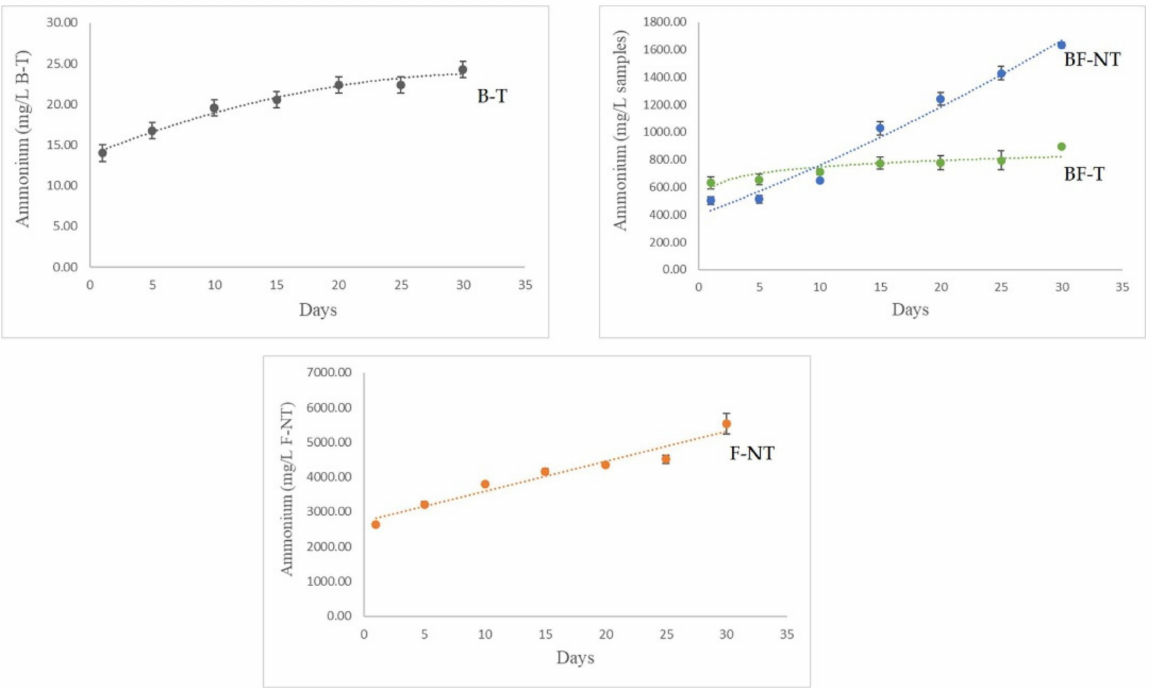
Figure 2. Ammonium release at five day intervals for 30 days of a water incubation experiment.